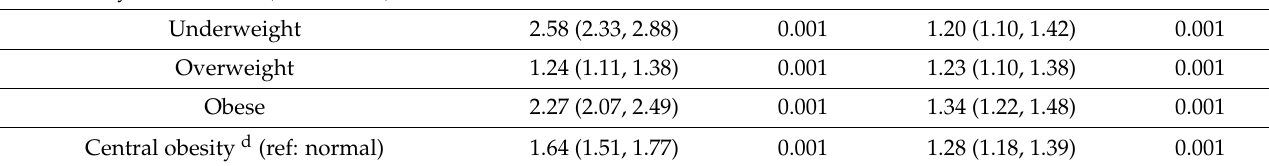
Model 1 Model 2 OR (95% CI) p OR (95% CI) p